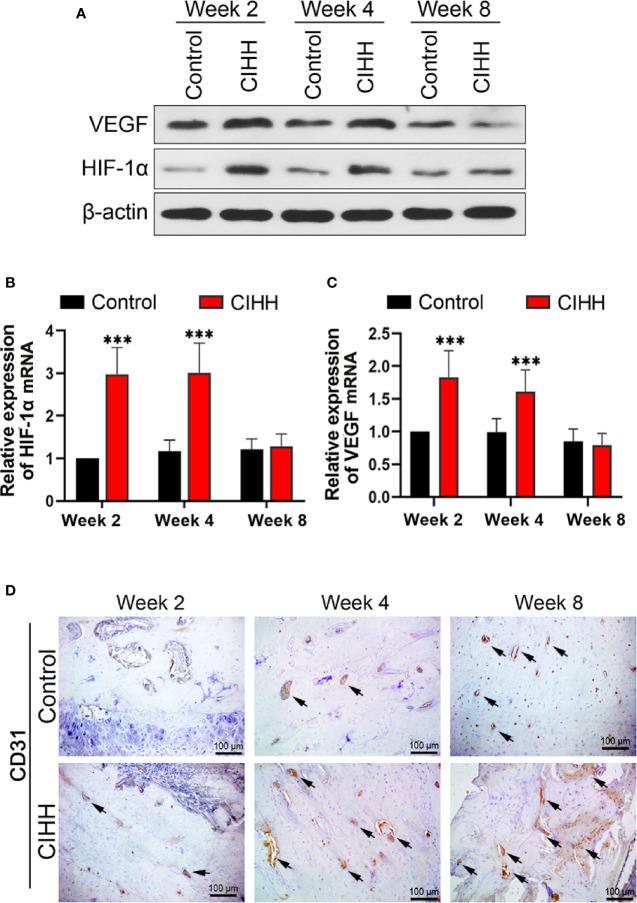
Angiogenesis. (A) Western blot images of HIF-1α, VEGF, and β-actin in the callus area. (B) Quantitative real-time PCR of the callus HIF-1α. (C) Quantitative real-time PCR of the callus VEGF. (D) Immunohistochemistry of CD31 within the woven bone. Magnification, ×200, scale bar = 100 µm. The typical CD31-positive capillaries were indicated by arrows. n=6, Mean ± SD, ***p < 0.01.